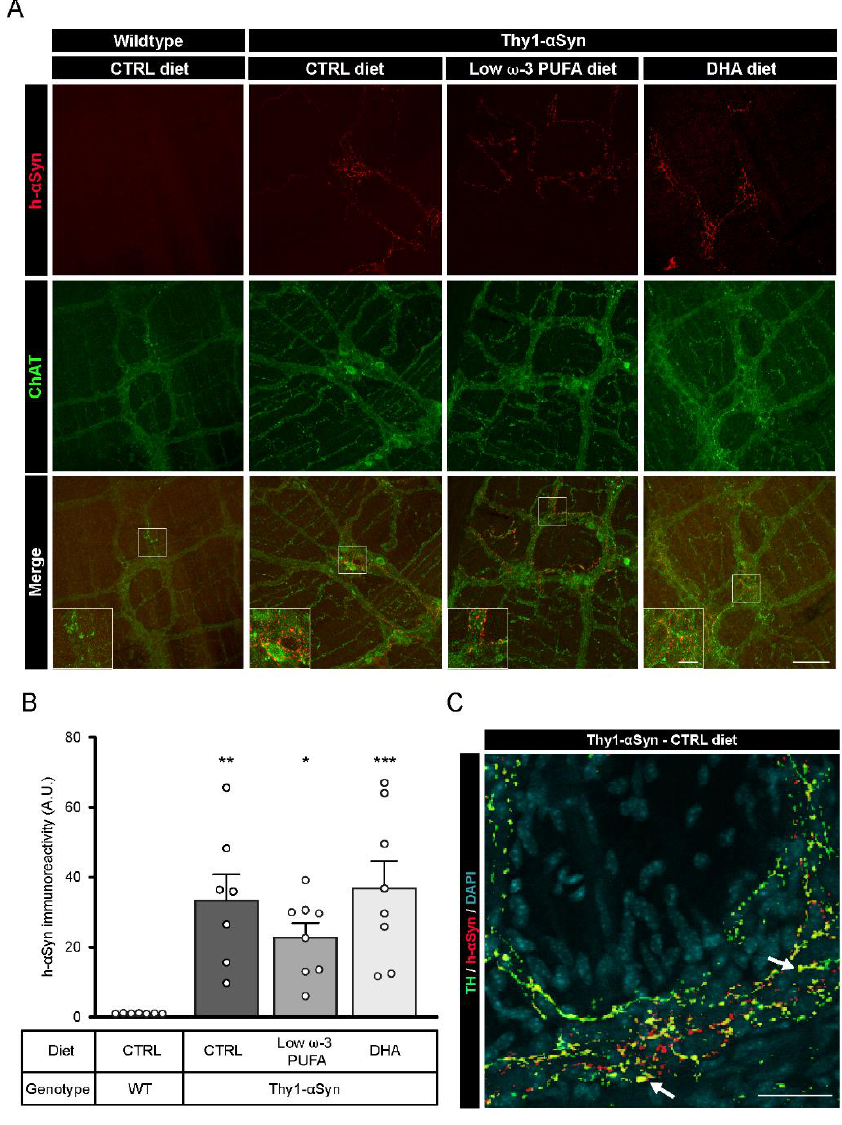
Figure 2. Presence of αSyn in the myenteric plexus of Thy1-αSyn mice. ( A ) Immunofluorescence of ChAT + neurons (green) and αSyn (red) confirms the presence of human αSyn in the Thy1-αSyn model ENS and absence of the protein in the wild-type littermate. Scale bar = 60 µm; Close-up scale bar = 15 µm. ( B ) Quantification of wild-type human αSyn by immunoreactivity in the myenteric plexus reveals a higher level of the protein in Thy1-αSyn mice compared with a wild-type littermate, but no difference among diets (one-way ANOVA: p = 0.0005). Tukey’s post-hoc tests: * p < 0.05, ** p < 0.01 and *** p < 0.001 compared with wild-type mice. ( C ) Photomicrographs of the myenteric plexus showing TH + neurons (green) and α Syn (red) reveal the presence of α Syn in TH + varicosities (yellow), as indicated by the white arrow. Scale bar = 30 µ m. Abbreviations: h- α Syn, human alpha-synuclein; A.U., arbitrary unit; ChAT, choline acetyltransferase; CTRL, control; DHA, docosahexaenoic acid; ENS, enteric nervous system; WT, wild-type. (white dots) show an increase of varicosities per 100 µ m of dendrites in transgenic mice fed with DHA-enriched diet compared to control